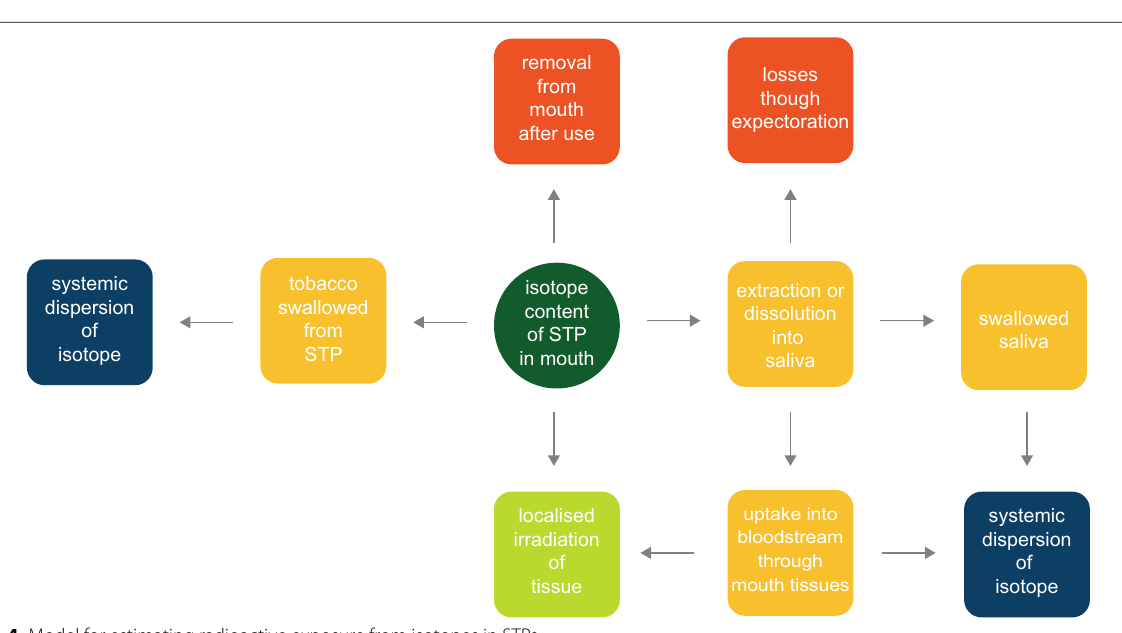
Fig. 4 Model for estimating radioactive exposure from isotopes in